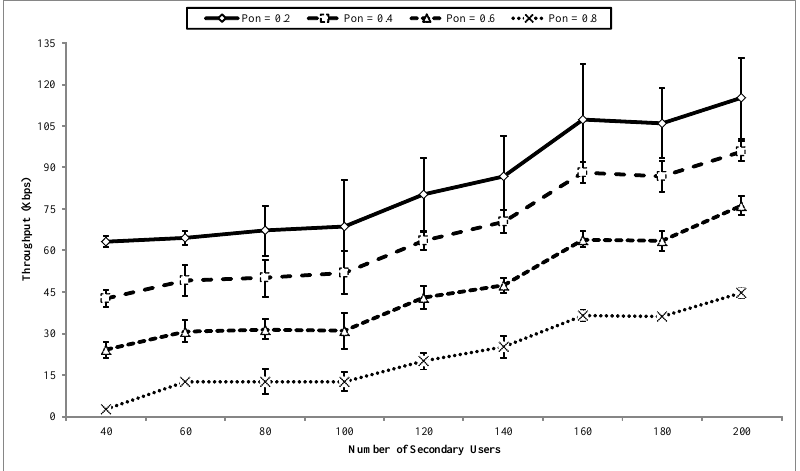
Figure 11. Throughput vs . number of CRSN nodes in the